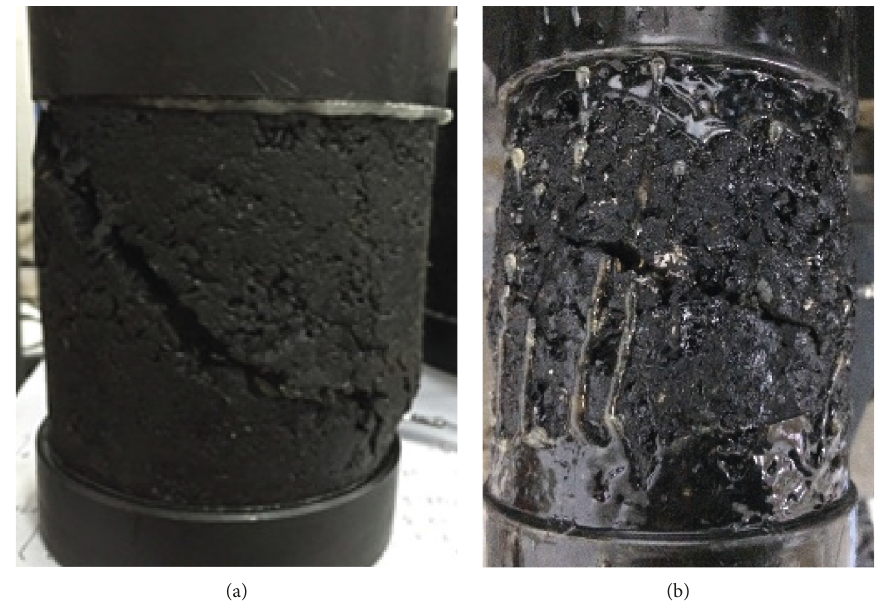
Figure 14: Failure of laboratory specimens: (a) AC-13 and (b) SMA-13.